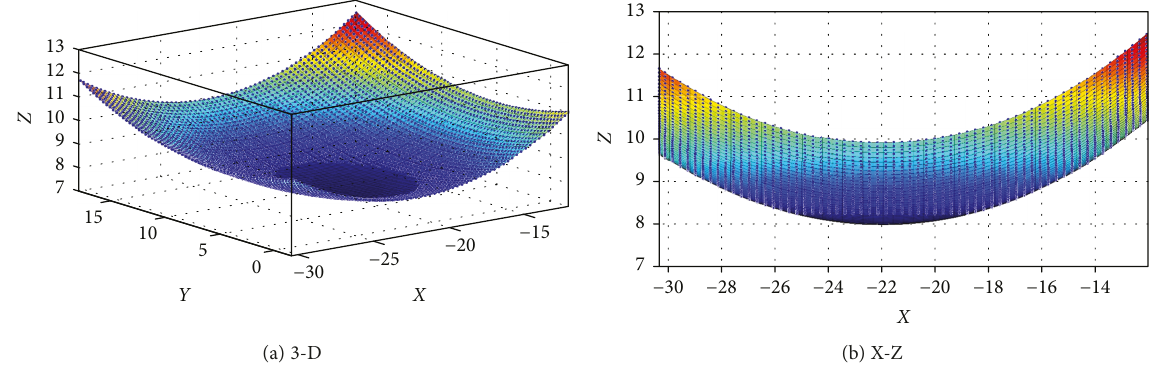
Figure 3: Computational simulated volume removal test (the dark blue area is the worn region).